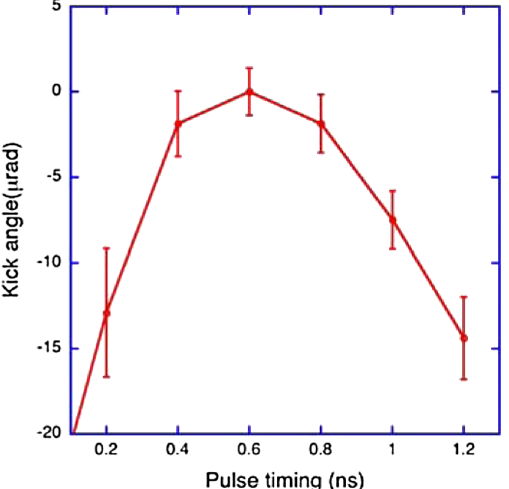
FIG. 13. The measured kick angle difference as a function of the kicker pulse